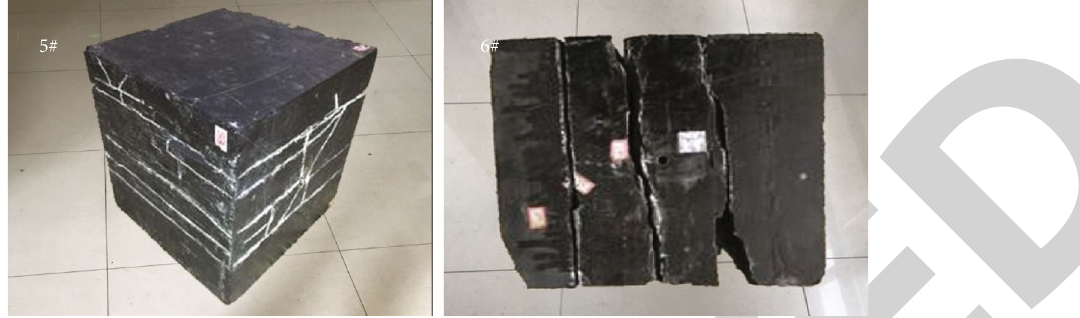
Figure 15: Fracture geometry of after fracturing test super fi cial carbon dioxide fracturing.